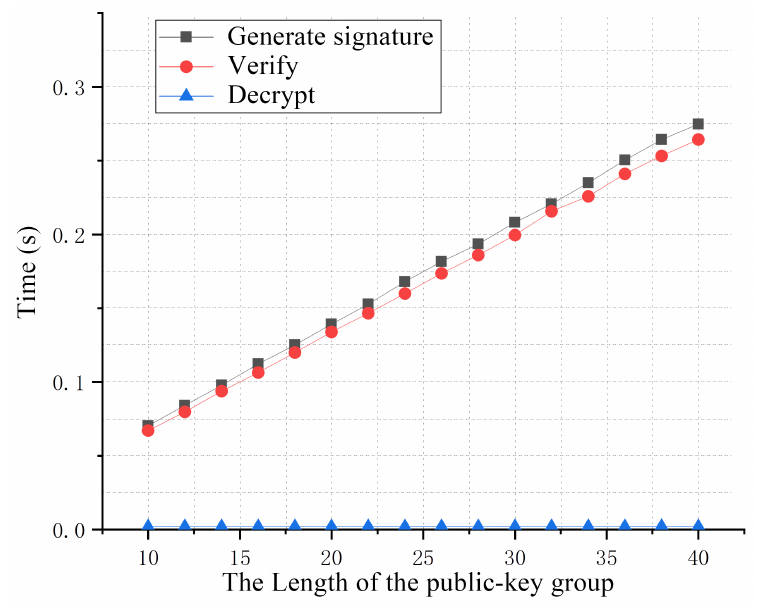
Figure 3. The relation between the length of the public-key group and the running time of the algorithm.